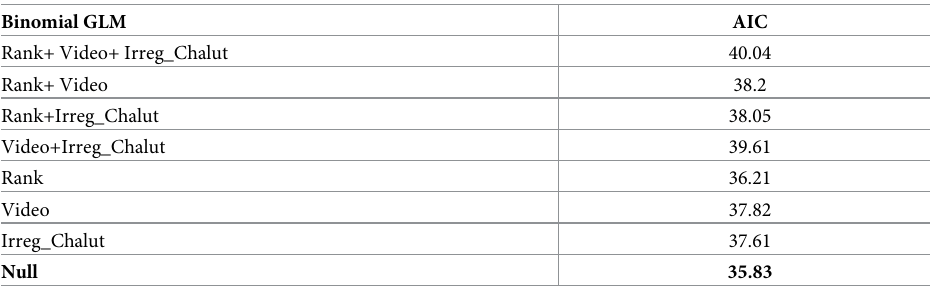
Table 2. Probability of success.